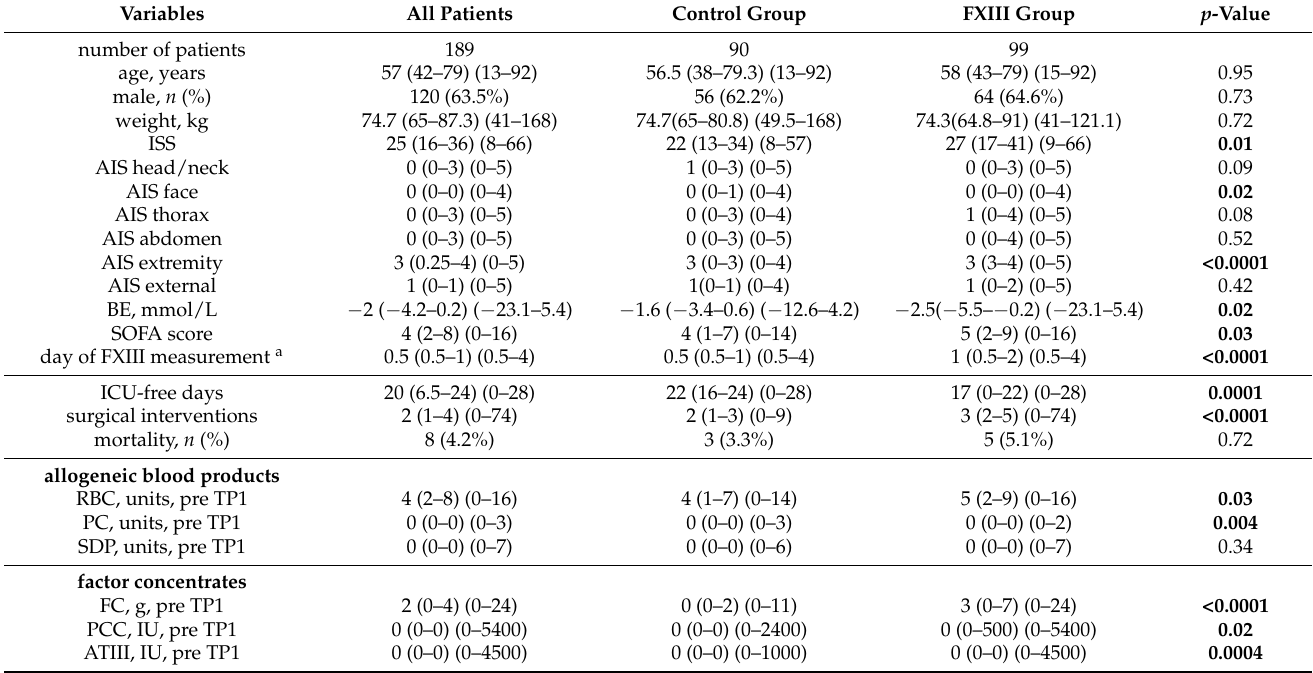
Table 1. Demographic and clinical data and allogeneic blood transfusion and coagulation factor concentrate administration prior to the initial FXIII level measurement of all included